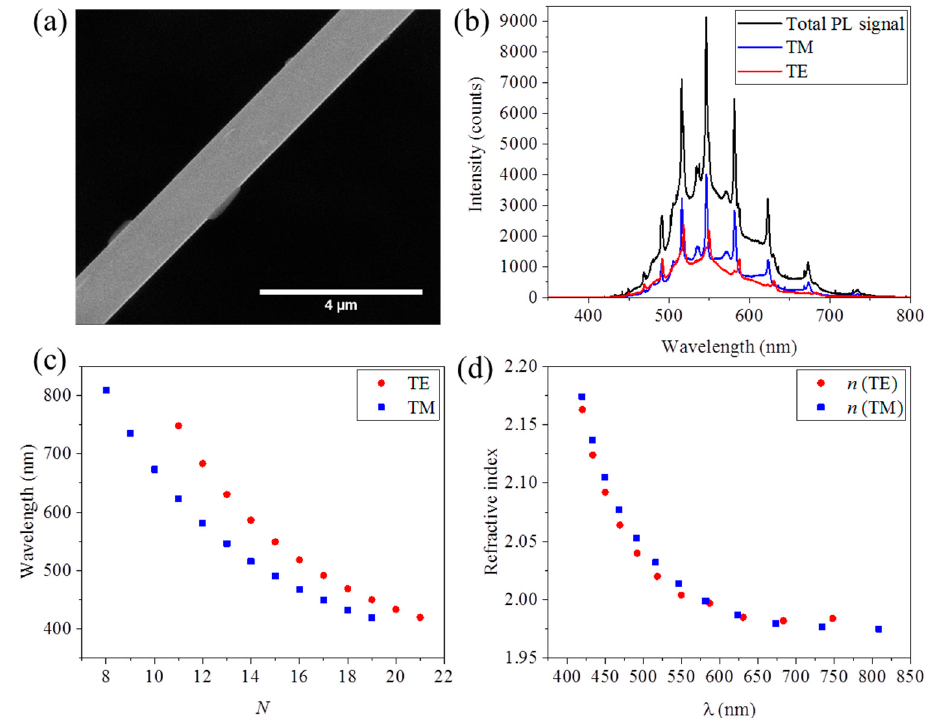
Figure 6. Analysis of the whispering gallery modes in region (iii). The measured length side “a” measured in the ( a ) SEM images was 0.72 µm. ( b ) µ-PL spectra for all the polarization conditions, ( c ) interference order N of the peaks observed in the spectra, and ( d ) estimation of the refractive index from the wavelength that virtually overlapped for both polarizations.